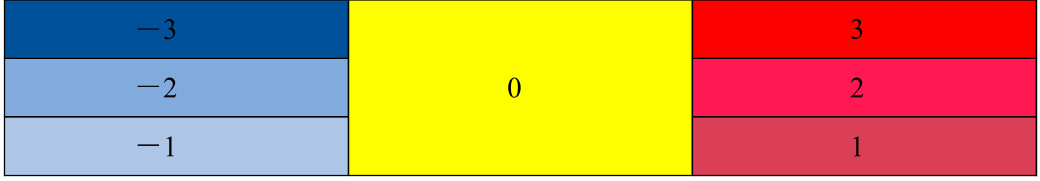
Figure 7. An example of hot/cold